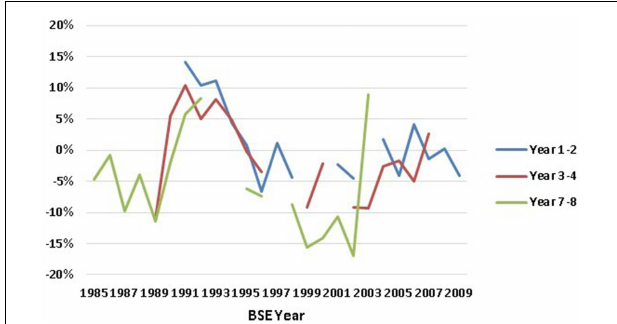
FIGURE 4 | Gender gap in retention in engineering, by BSE-year, calculated as coefficients on Female X BSE-year interaction terms in regression results of Table A1 in Supplementary Material. Data Source: NSF SESTAT Surveys